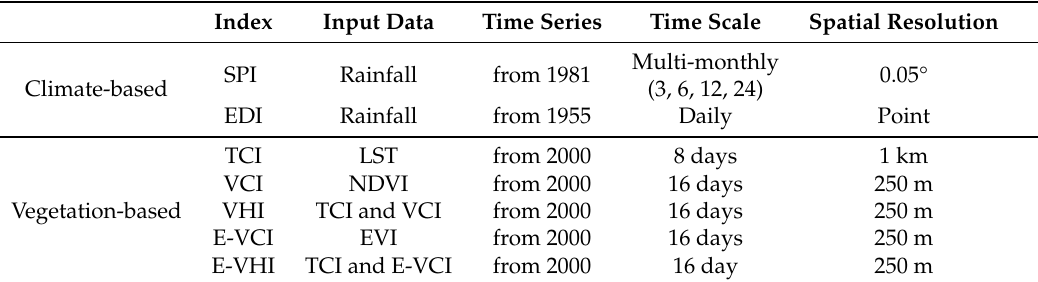
Table 2. Set of indices selected for the monitoring system section.